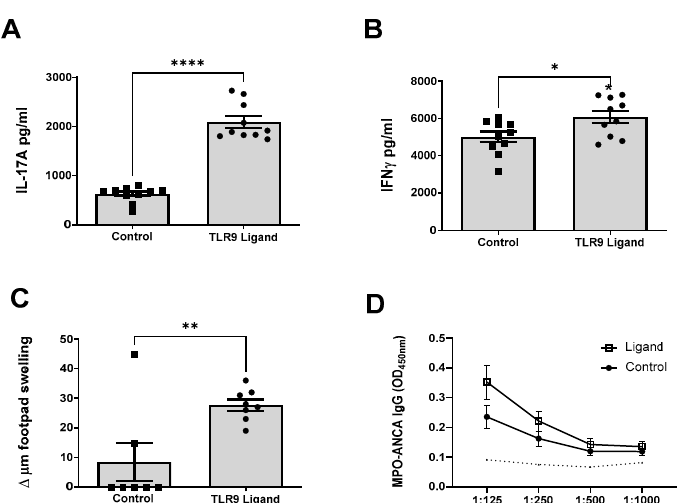
Figure 2. TLR9 ligation of MPO pulsed dendritic cells promotes early MPO autoimmunity. Early Immune Responses. MPO-stimulated mouse splenocyte cytokine production (day 10). ( A ): Increased production of interleukin 17A (IL-17A) in mice receiving TLR9 stimulated MPO pulsed DCs compared to Control stimulated MPO pulsed DCs. ( B ): Increased production of interferon gamma (IFN- γ ) in mice receiving TLR9 stimulated MPO pulsed DCs. ( C ): Increased MPO specific dermal DTH response in mice receiving TLR9 stimulated MPO pulsed DCs. ( D ): No difference in serum MPO-ANCA was observed between groups. Dotted line represents the OD 450 of sera from control, OVA immunized mice receiving anti-GBM globulin. Bars show the mean +/ − SEM. * = p < 0.05, ** = p < 0.01, **** = p < 0.0001. DC = Dendritic cell. Mouse numbers for experiment: Control: n = 10, TLR9 Ligand: n = 10.